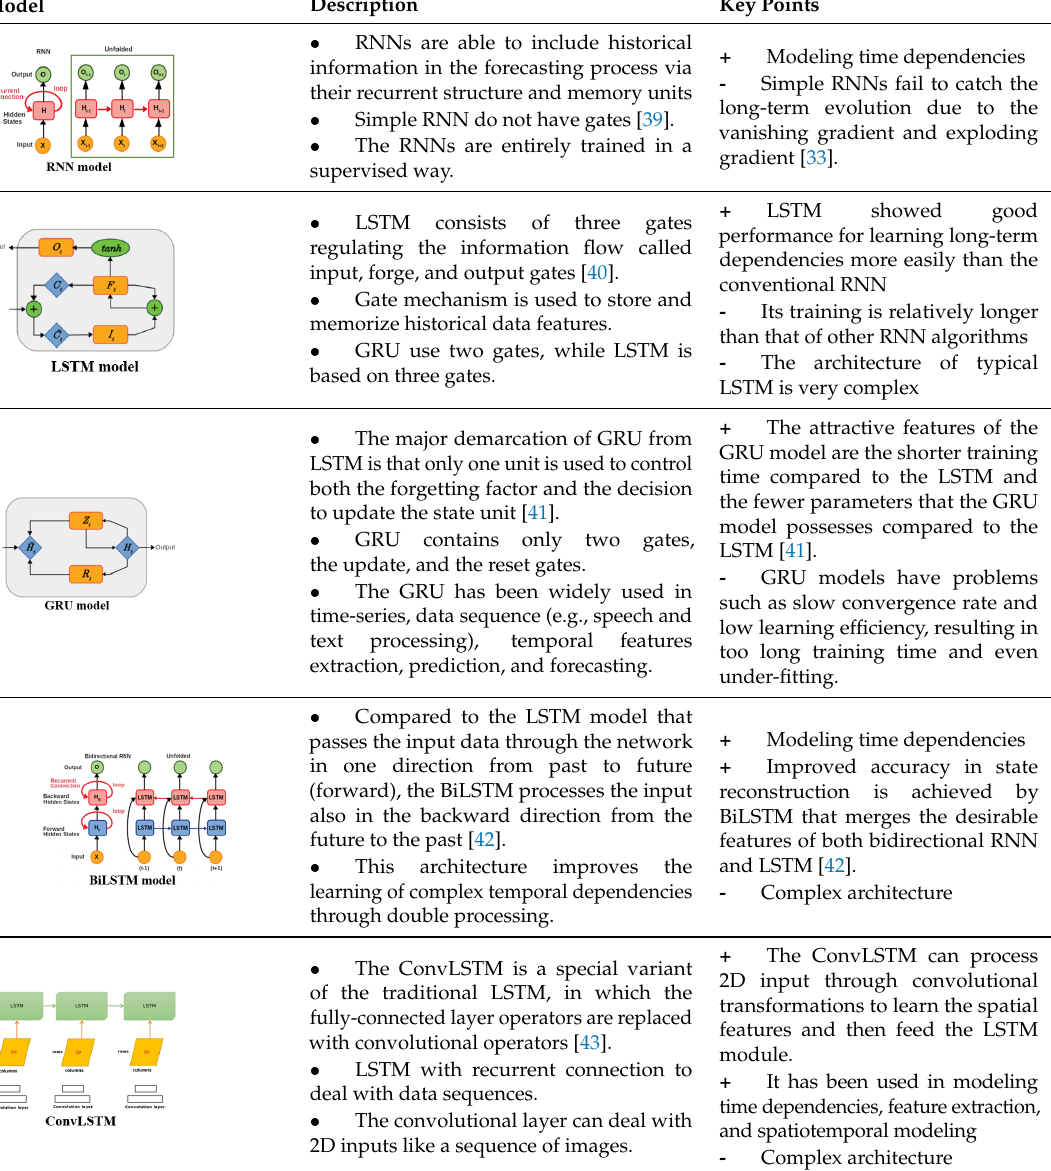
Table 1. The considered benchmark deep learning